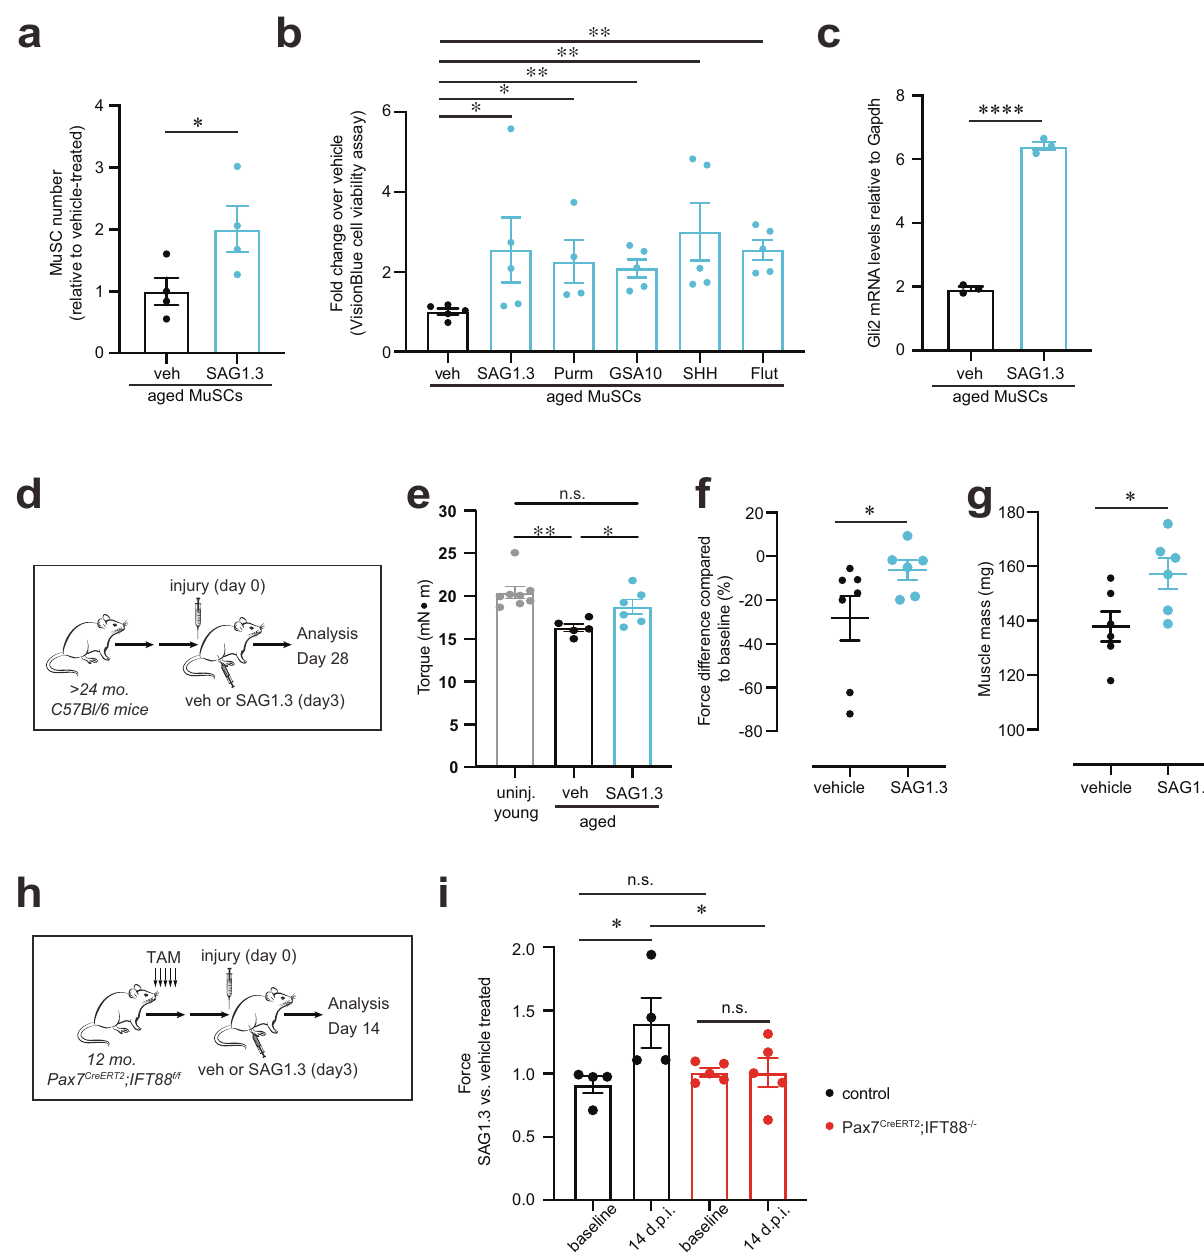
Fig. 5 SMO agonist promotes MuSC proliferation and function in aged MuSCs. a Proliferation of aged MuSCs (>24 mo) treated with vehicle (veh) or SAG1.3 (50 nM), shown as fold change normalized to vehicle treated ( n = 4 mice per condition, each with 3 technical replicates). b Proliferation of aged MuSCs treated with SMO agonist, shown as fold change normalized to vehicle treated (50 nM SAG1.3; 1 µ M Purm, Purmorphamine; 0.1 µ g/ml SHH, Sonic- Hedgehog; 1 µ M GSA-10; 25 nM; Flut, Fluticasone) ( n = 5 technical replicates per condition). c Expression levels of SMO downstream target Gli2 in MuSCs 24 h after vehicle or SAG treatment ( n = 3 mice per condition). d – g Aged (>24 months) mice were injected with vehicle or SAG post-notexin injury and muscle regeneration was analyzed 4 weeks later as force recovery. d Experimental scheme. e Plantar fl exion tetanic torque (absolute values) ( n = 6